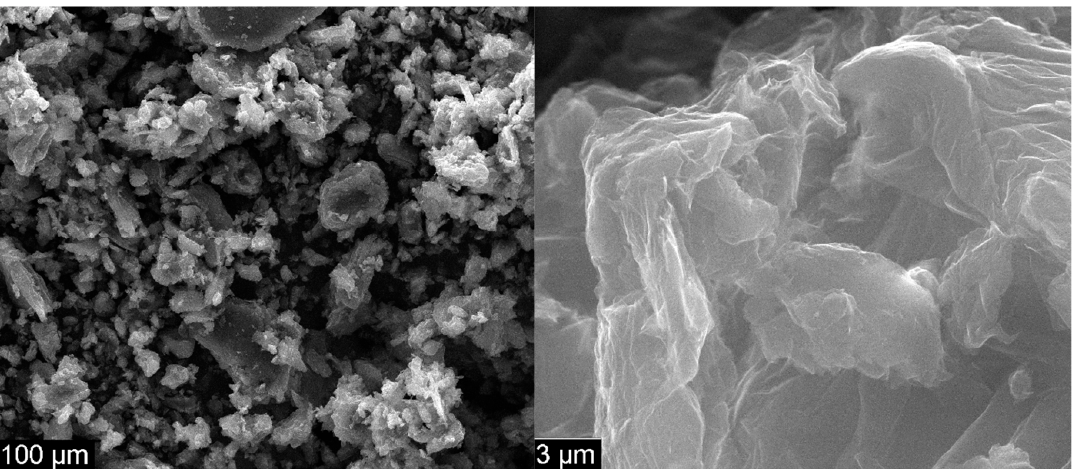
Figure 3. FTIR spectra for GO, CS/EDTA/GO 0.1% and CS/EDTA/GO 0.3%.